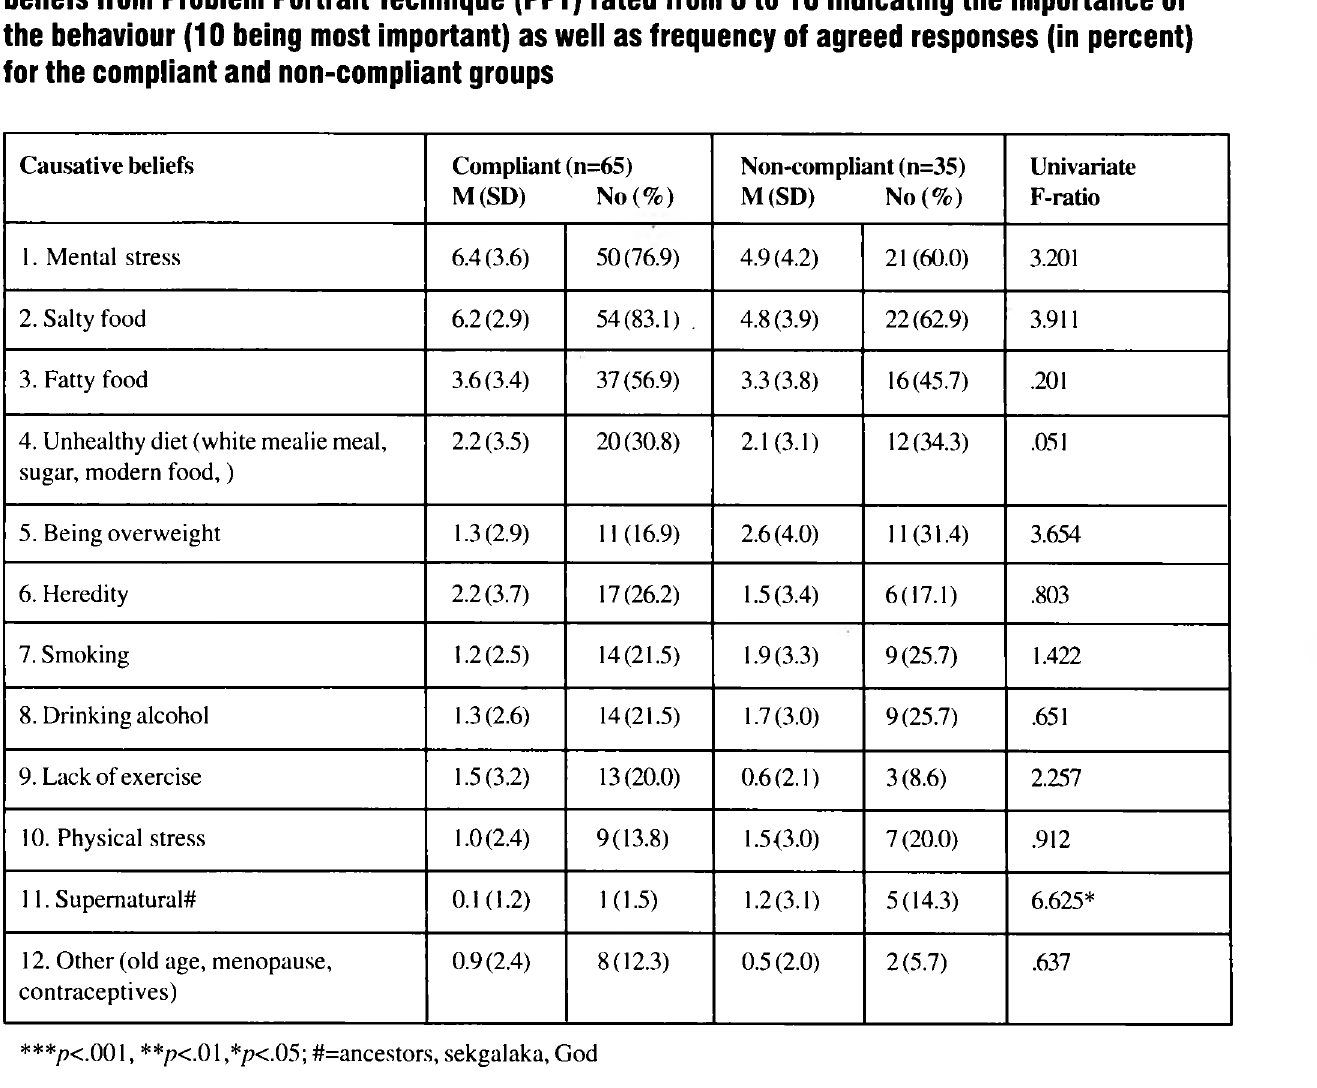
Table 3: Group means, standard deviations and significance tests of hypertensive causative beliefs from Problem Portrait Technique (PPT) rated from 0 to 10 indicating the importance of the behaviour (10 being most important) as well as frequency of agreed responses (in percent) for the compliant and non-compliant